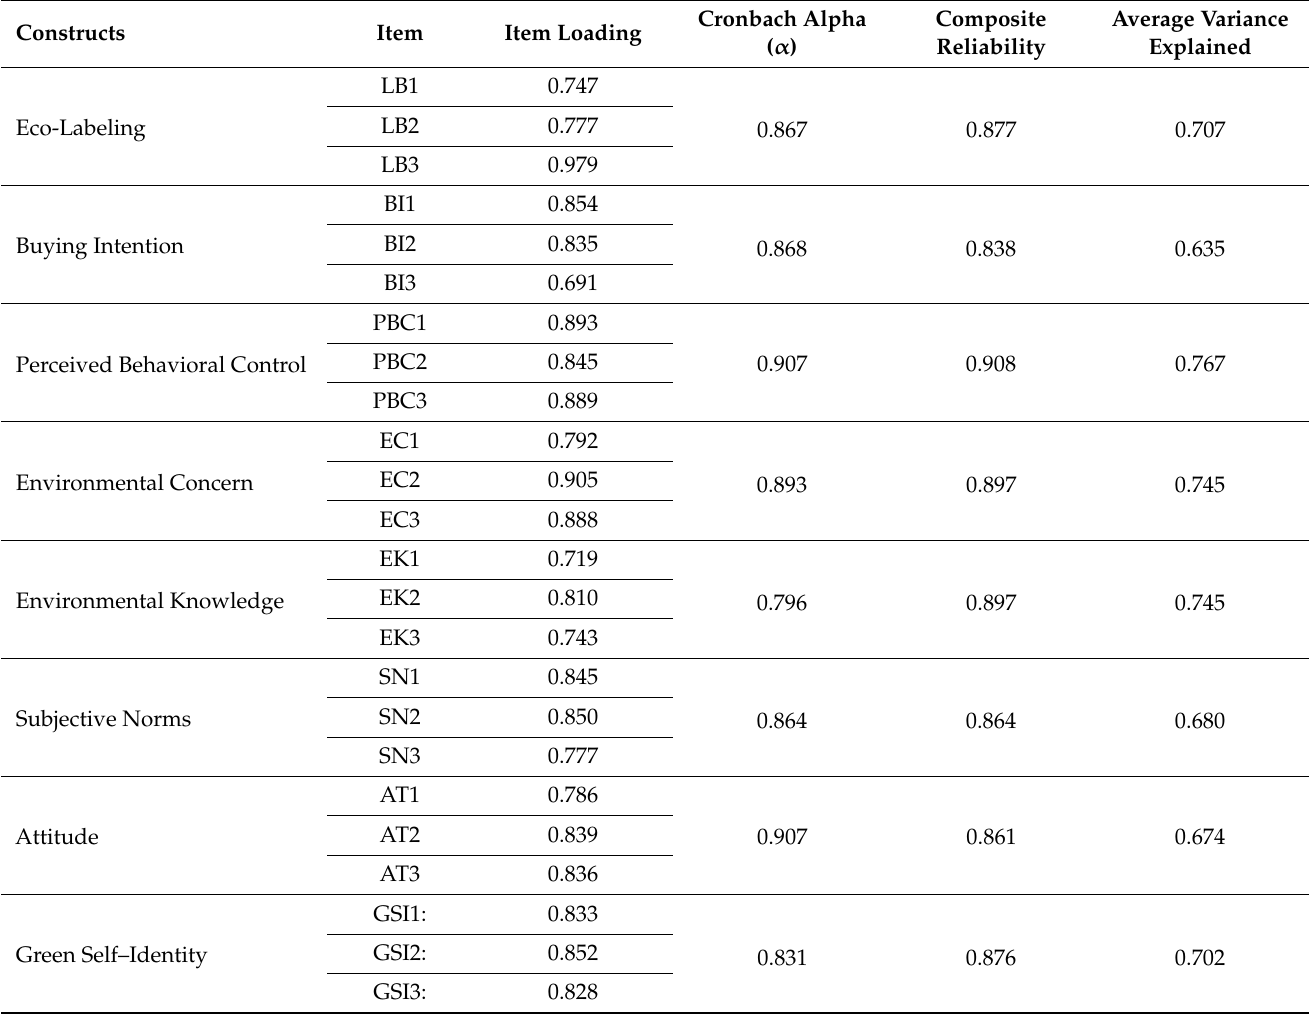
Table 3. Reliability and convergent validity.